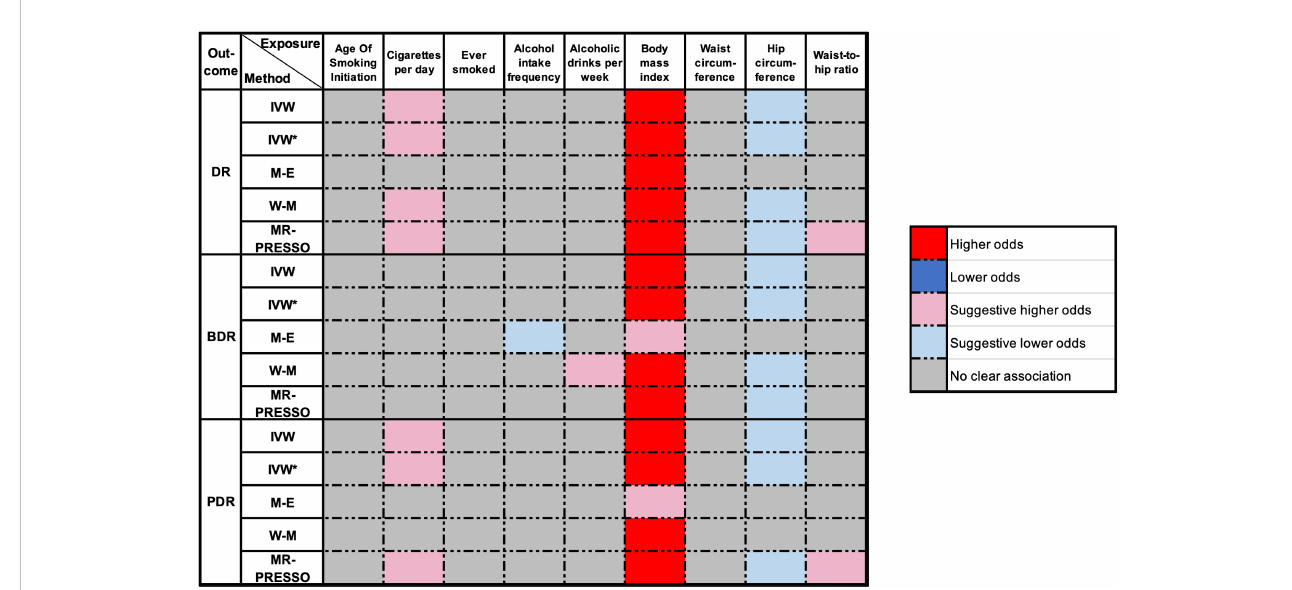
FIGURE 3 Overview of the main results of MR analyze. DR, diabetic retinopathy; BDR, background diabetic retinopathy; PDR, proliferative diabetic retinopathy; IVW, inverse ‐ variance weighted ( fi xed-effect); IVW*, Inverse variance weighted (multiplicative random-effects); MR, Mendelian randomization; M-E, MR Egger; W-M, weighted median; MR-PRESSO, MR Pleiotropy Residual Sum and Outlier. P-value < 1.852e -03 was regarded as a signi fi cant causal association, the P-value between 0.05 and 1.852e -03 was considered suggestive of a potential association.